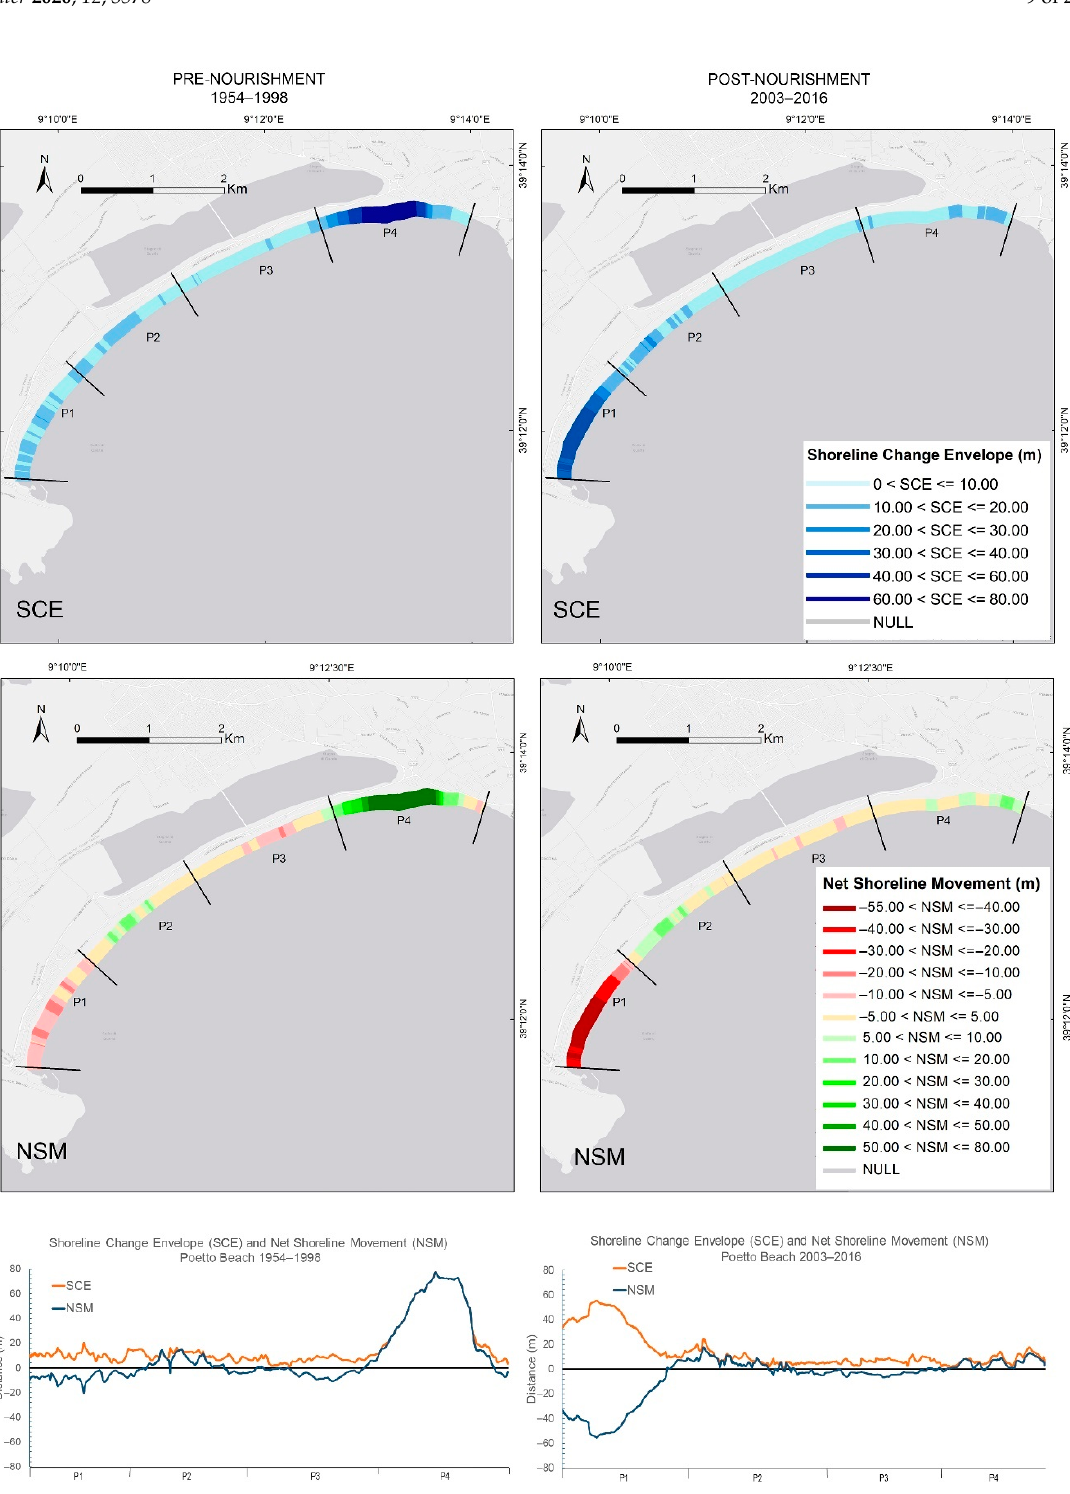
Figure 5. Maps (above) showing the spatial distribution of shoreline change envelope (SCE) and net shoreline movement (NSM) along the Poetto beach for pre-nourishment (1954–1998) ( left ) and post-nourishment (2003–2016) ( right ) years, superimposed with the limits of the four discriminated sectors (P1–P4); SCE and NSM trends (below) plotted against distance (west to east), with the x-axis showing the limits of the P1 − P4 sectors. Positive values of NSM indicate areas of accretion, whilst negative values indicate areas of shoreline retreat.